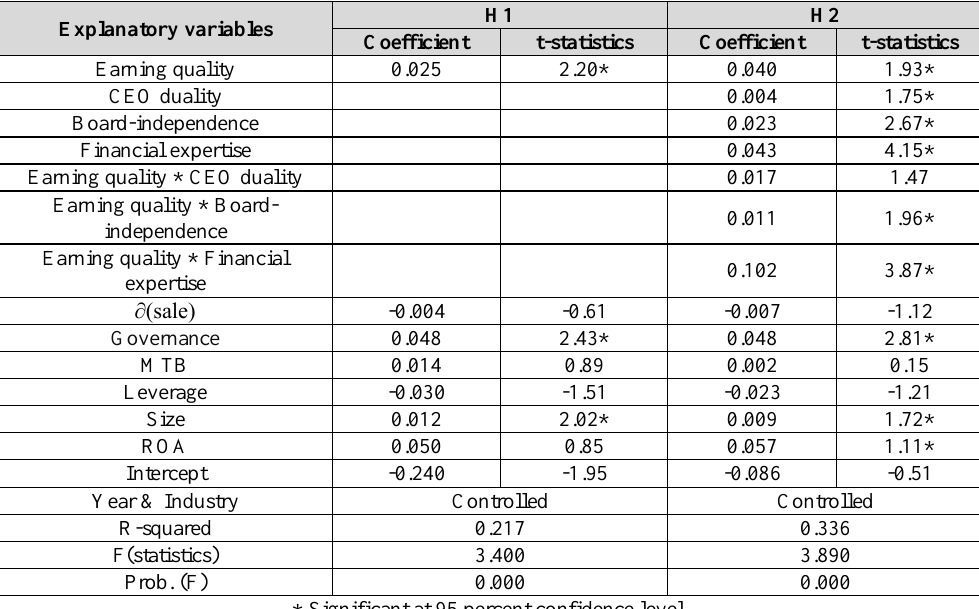
Table 4. cluster panel estimation